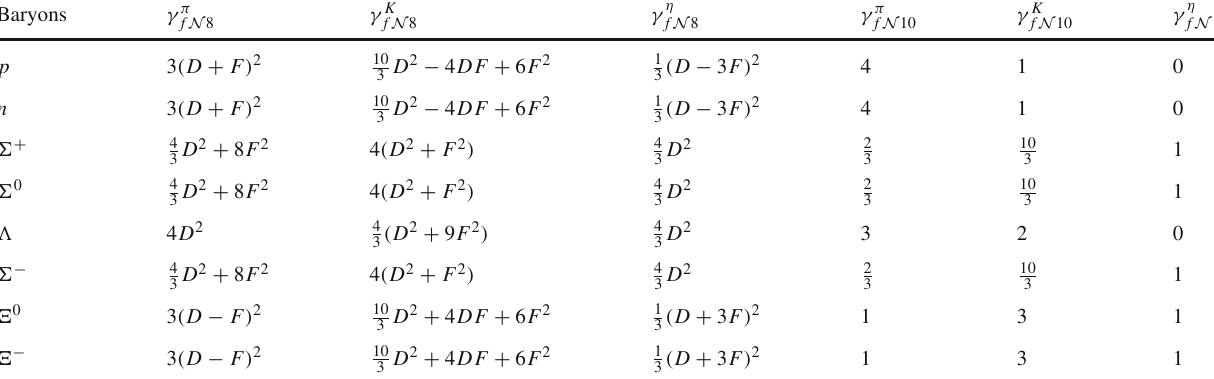
Table 12 The coefficients of the loop corrections to the decuplet to octet baryon transition magnetic moments from Figs. 2(o) and 2(p) Baryons